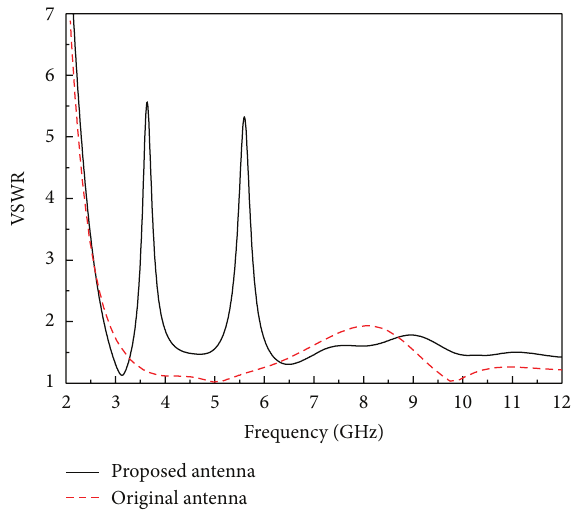
Figure 5: Simulated VSWRs of the proposed antenna and the original